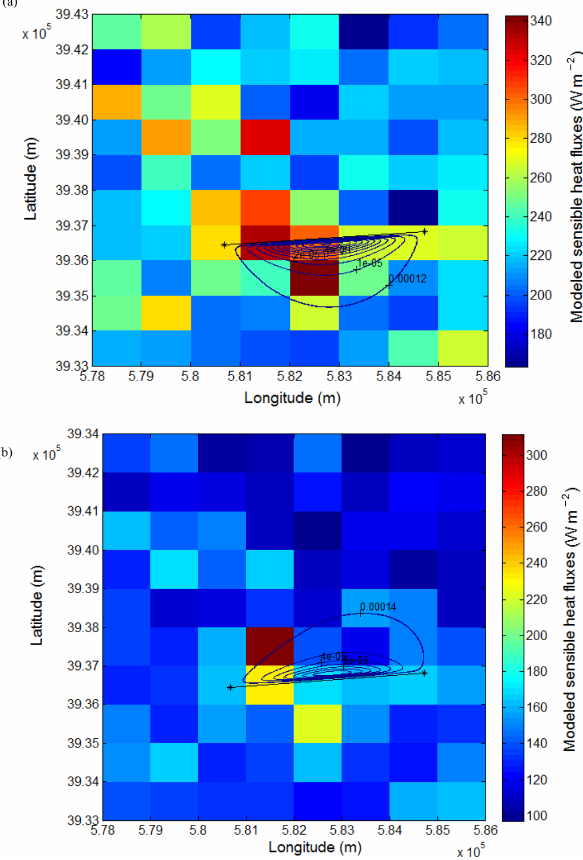
Figure 6. Model-derived sensible heat fluxes and footprints for (a) DOY 2013-082 at Aqua overpass time and (b) DOY 2014-208 at Terra overpass time. The colored area shows the modeled flux and the contours shows the surface source area contributing to the scintillometer